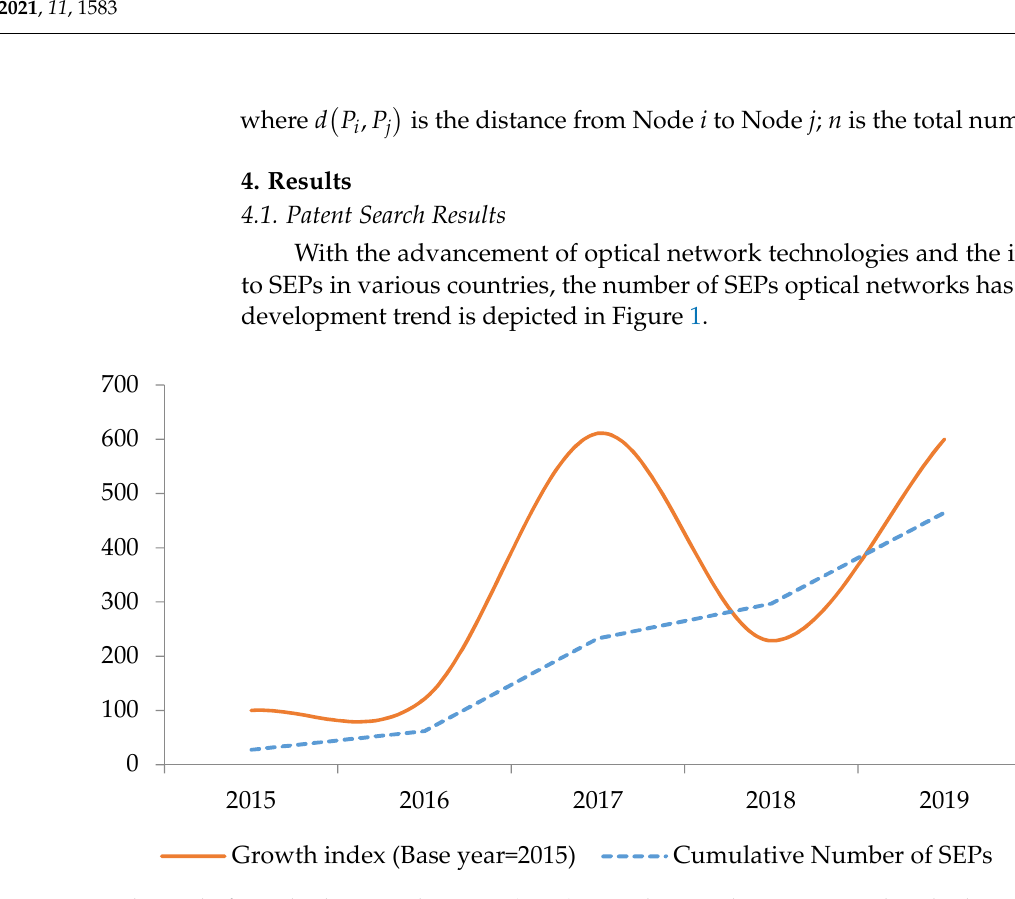
Figure 1. Growth trend of standard essential patents (SEPs) optical networks. Note: One hundred was applied as the number of SEPs in the base year (2015). In subsequent years, the growth index was (the number of SEPs of that year/the number of SEPs in the base year) × 100. Therefore, in 2019, the growth index was nearly 600 which means that it was approximately six times the growth index of 2015, which was 100. The cumulative number of SEPs denotes the accumulated number of SEPs each year.